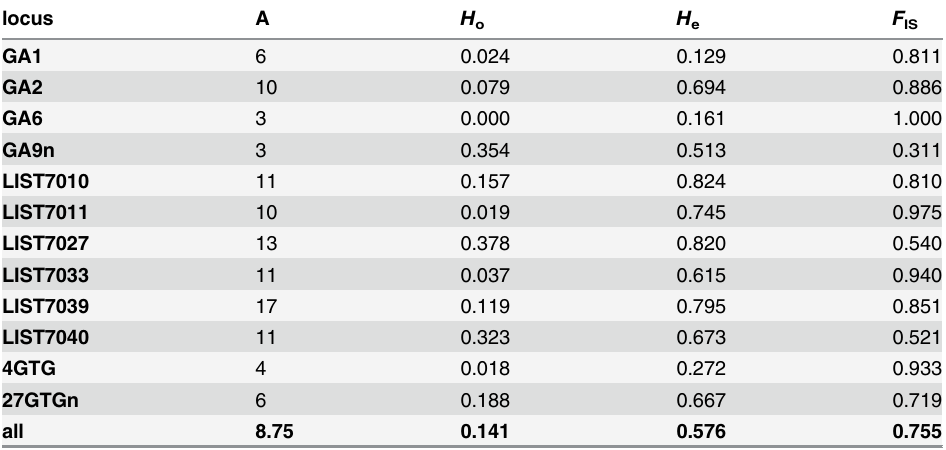
Table 1. Descriptive statistics per